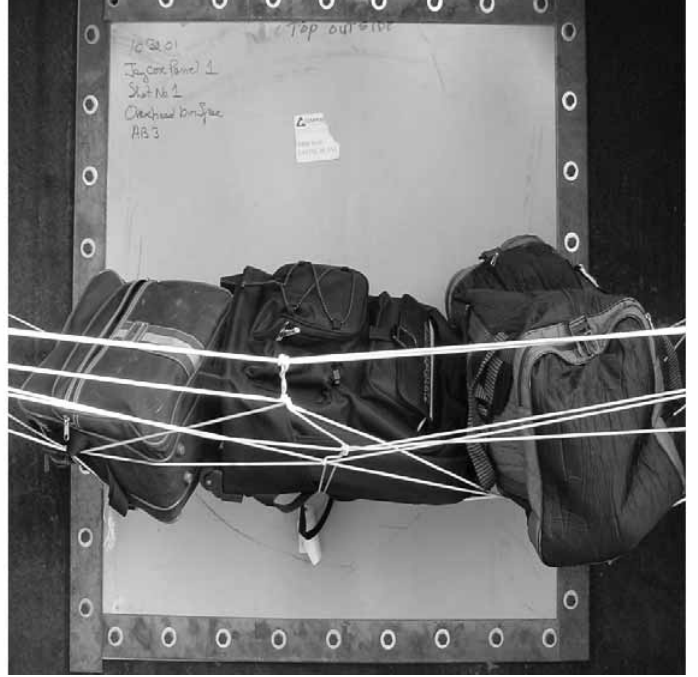
Fig. 3. Shock holing test set-up for test